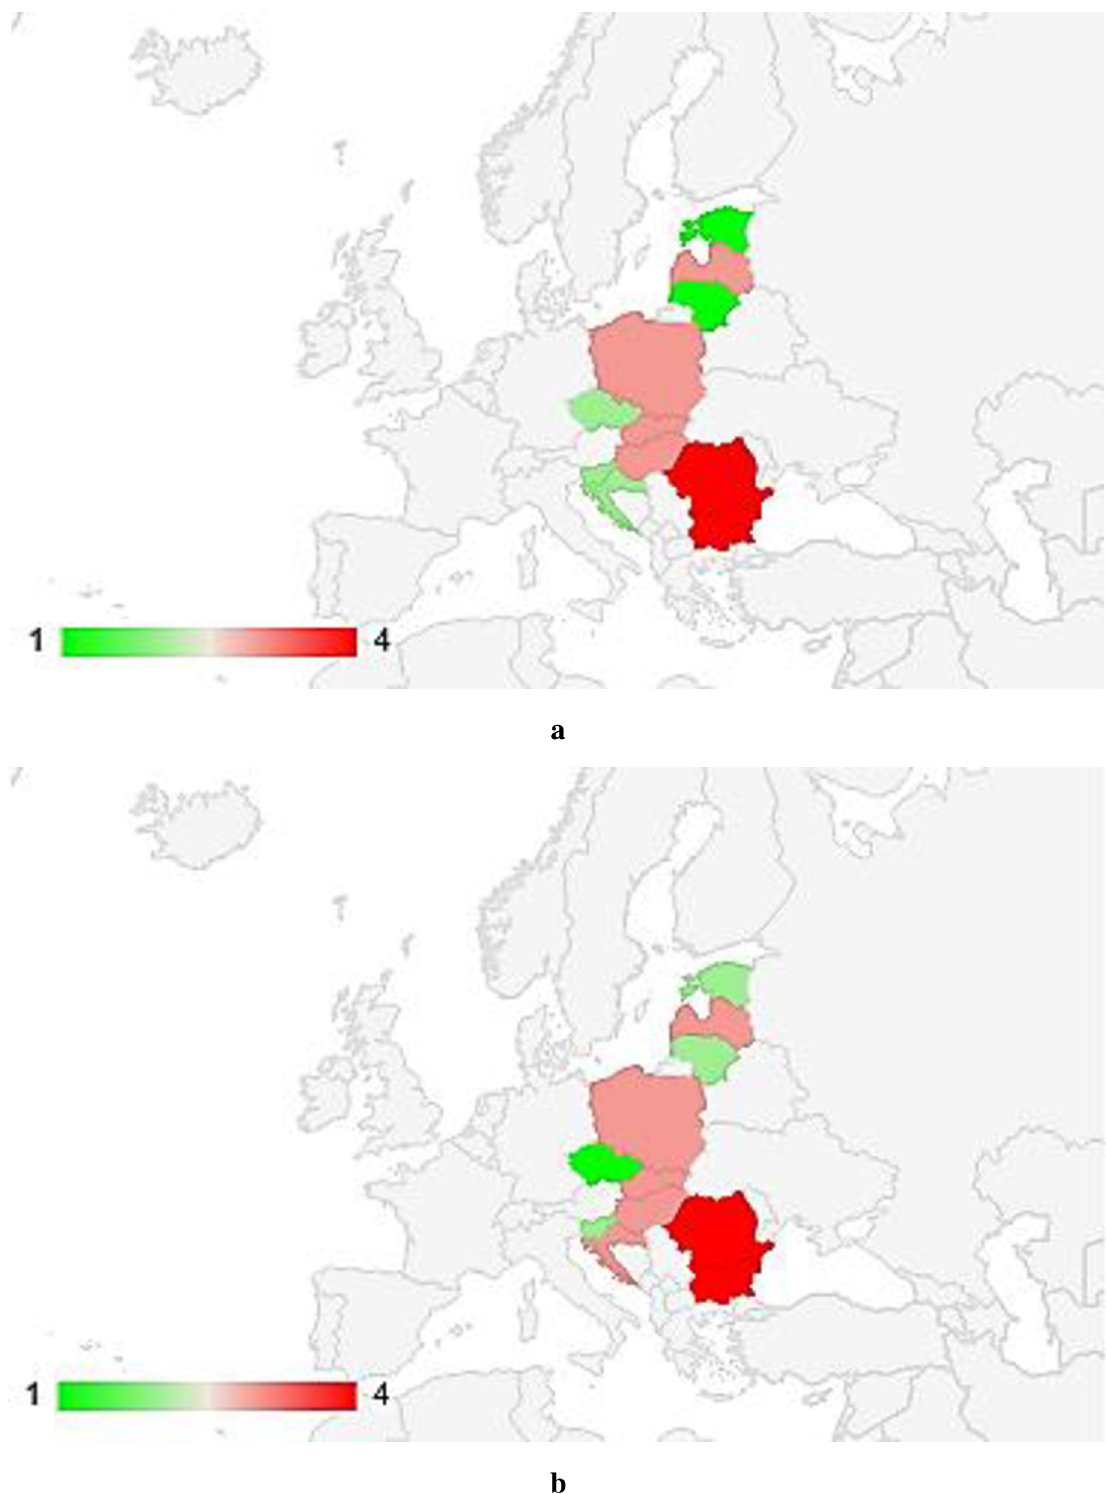
Fig 10. Assessment of the level of digital maturity among enterprises in the CEE countries by the mean- rank method (1 –high level, 2 –average high level, 3 –average low level, 4 –low level).